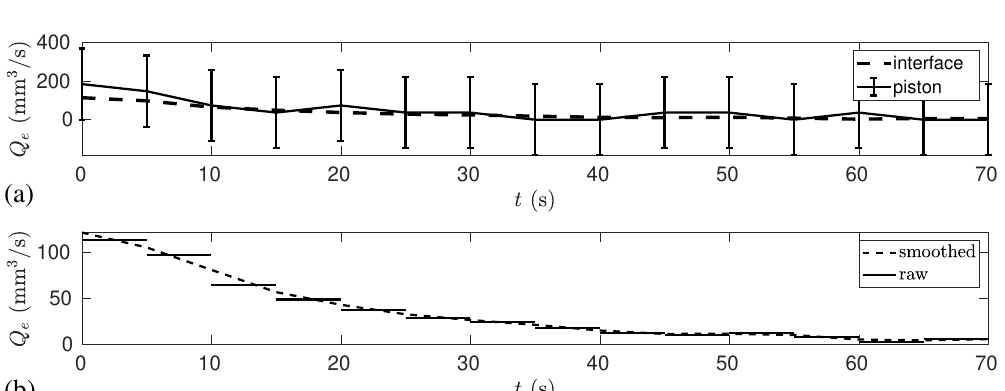
Figure 5. ICF-1 Q e ( a ) measurement error for piston (dashed, box-whisker) and interfacial (dashed) tracking, where whisker length and dashed line thickness indicate measurement error for each respectively and ( b ) trapezoidal-integrated smooth (dashed) alongside raw (discontinuous black,